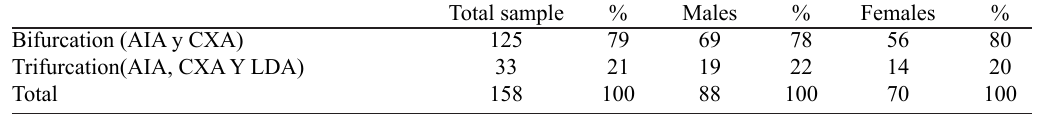
Table 1. Division of the left coronary artery in anterior interventricular artery (AIA), circumflex artery (CXA) and left diagonal artery (LDA), by gender